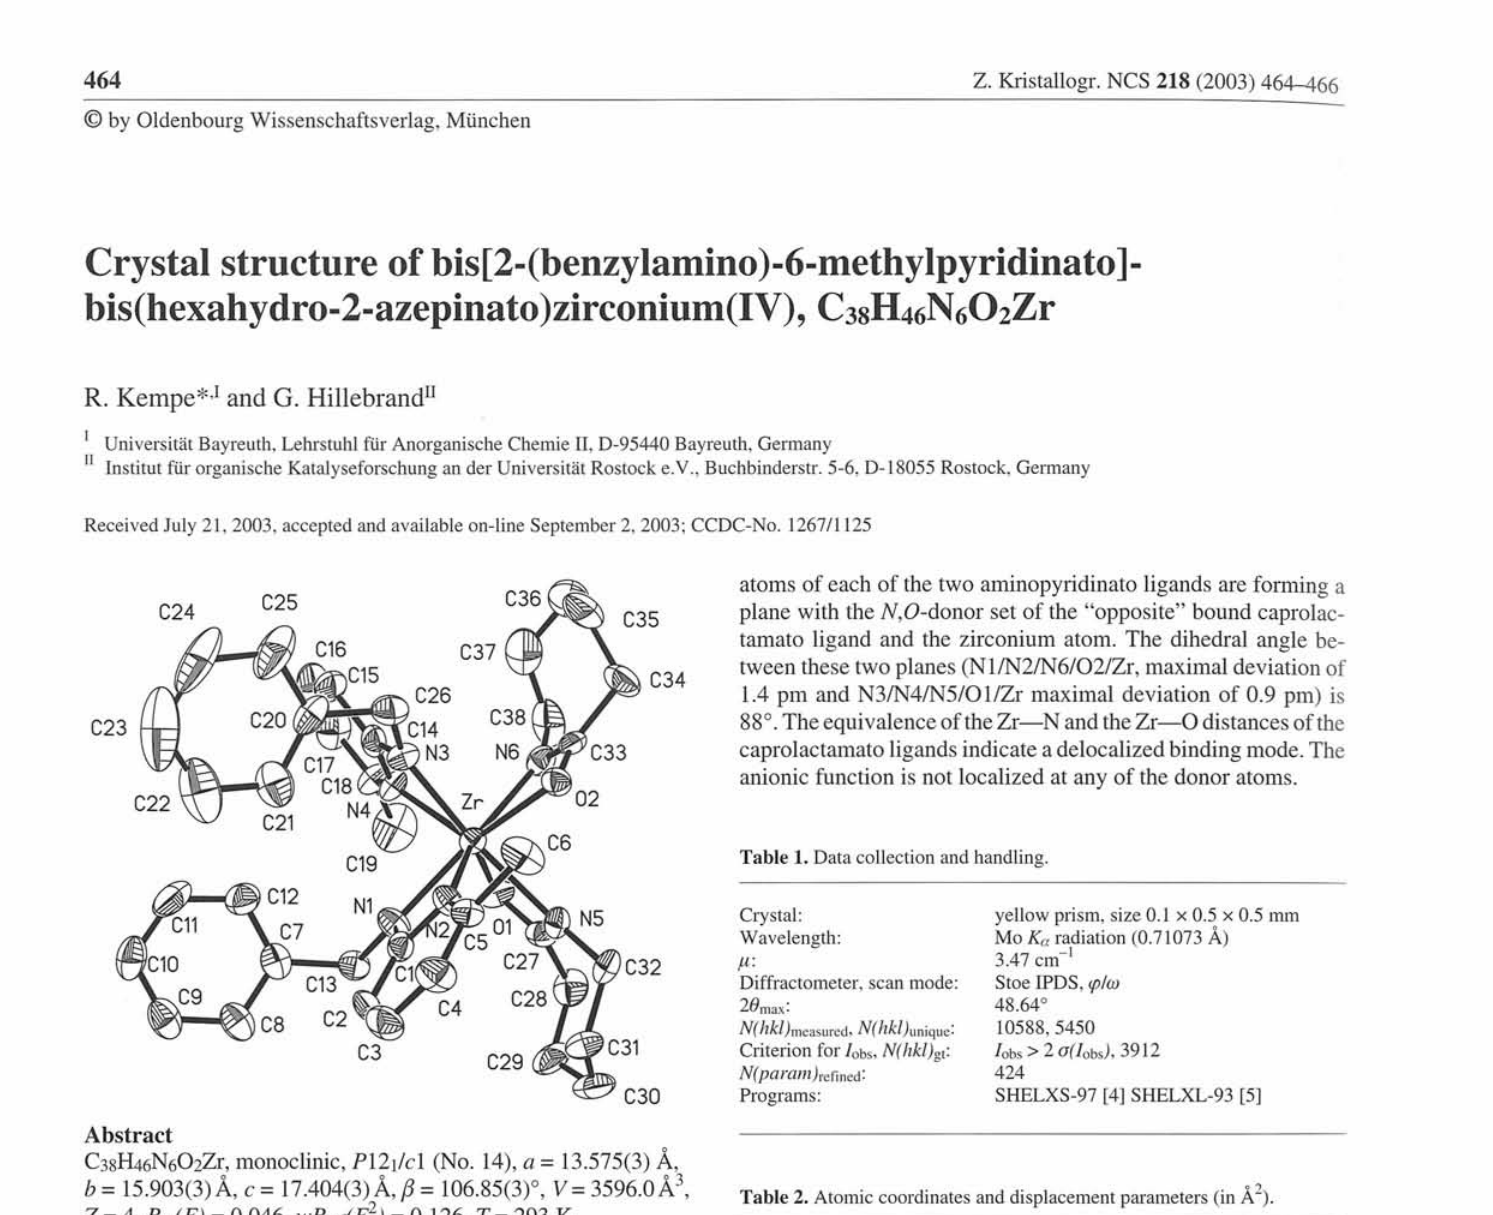
Table 2. Atomic coordinates and displacement parameters (in Â 1